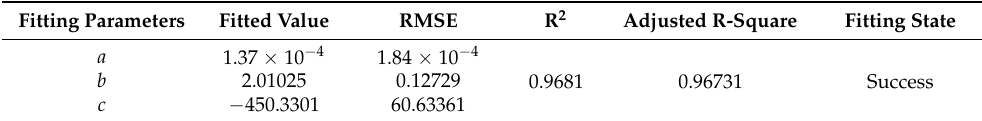
Table 2. ψ - R e Fitting statistics.